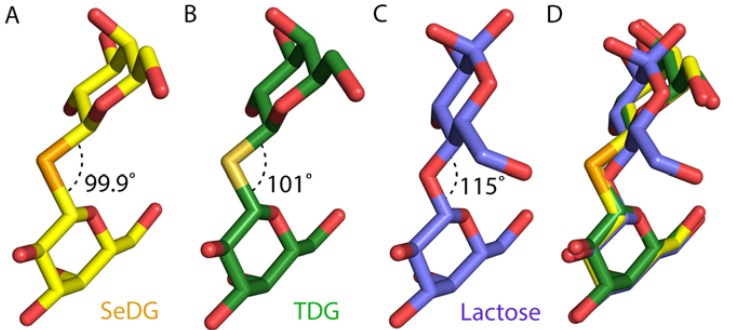
Figure 4. ( A ) Bond angle between C-Se-C in SeDG (yellow sticks) is 99.9 ◦ (PDB ID 7RDP). ( B ) Bond angle between C-S-C in thiodigalactoside (TDG, green sticks) is 101 ◦ (PDB ID 4JC1). ( C ) Bond angle between C ‐ O ‐ C in lactose (purple sticks) is 115° (PDB ID 2NN8). ( D ) Superimposition of SeDG, TDG and lactose indicates an identical position for inner galactose ring for all three molecules in the car ‐ bohydrate binding site of h Gal ‐ 3, whilst there is a slight deviation observed on SeDG distal galactose ring compared to glucose of lactose. However, the distal galactose of TDG and SeDG occupies an identical position within the h Gal ‐ 3 carbohydrate binding site.